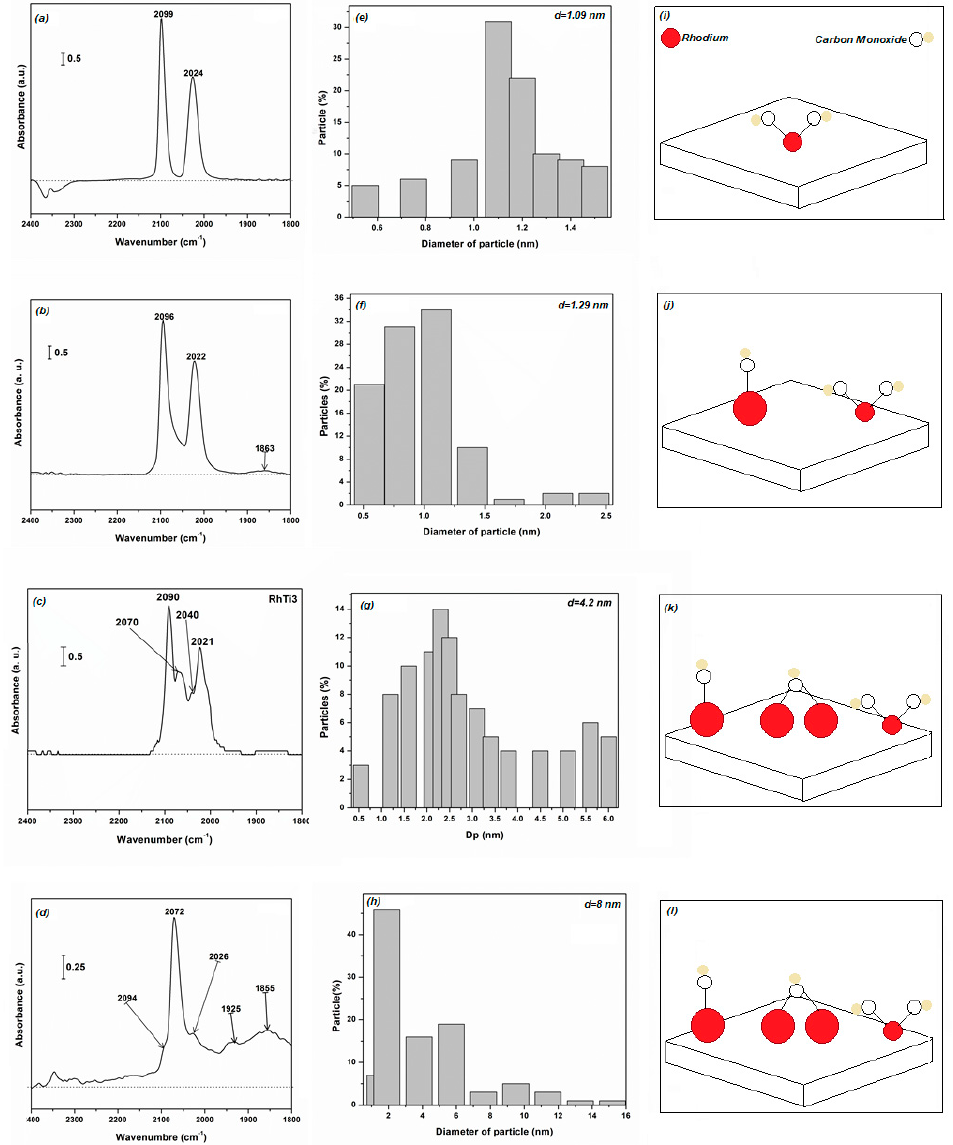
Figure 6. Infrared spectra of CO adsorption ( a – d ) for RhTi1, RhTi2, RhTi3 and RhTi4. Particle size distribution ( e – h ) for RhTi1, RhTi2, RhTi3 and RhTi4. Diagram of the interaction of CO with rhodium particles ( i – l ) for RhTi1, RhTi2, RhTi3 and RhTi4.